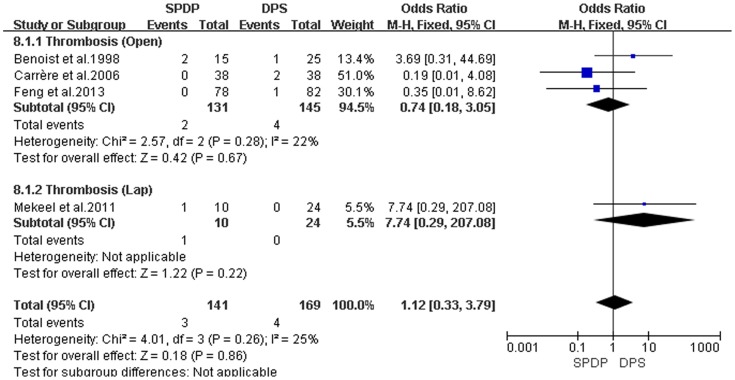
Thrombosis (IV, Inverse variance; M-H, Mantel-Haenszel; CI, Confidence Interval; SD, standard deviation).